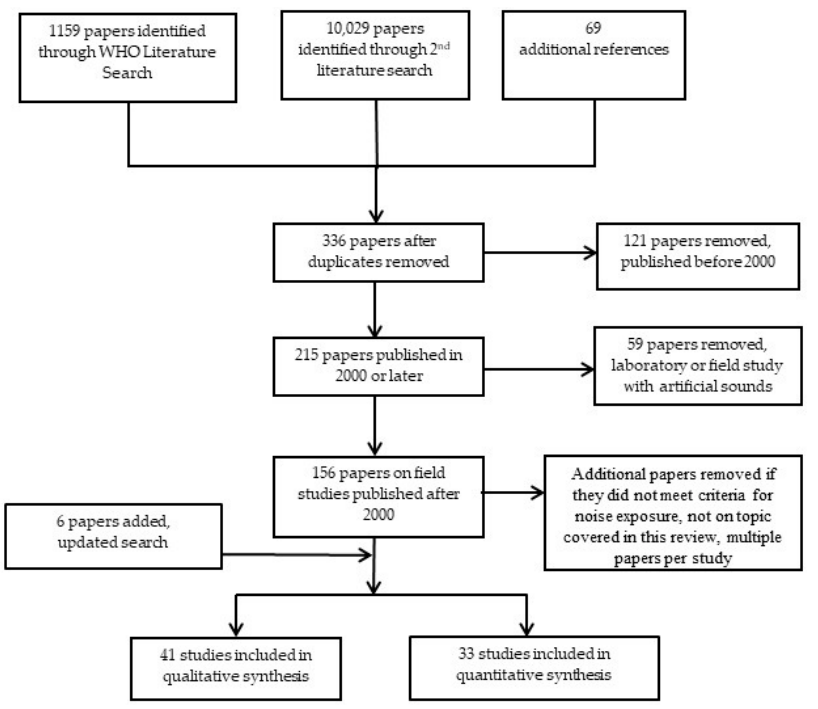
Figure 2. Flow of study